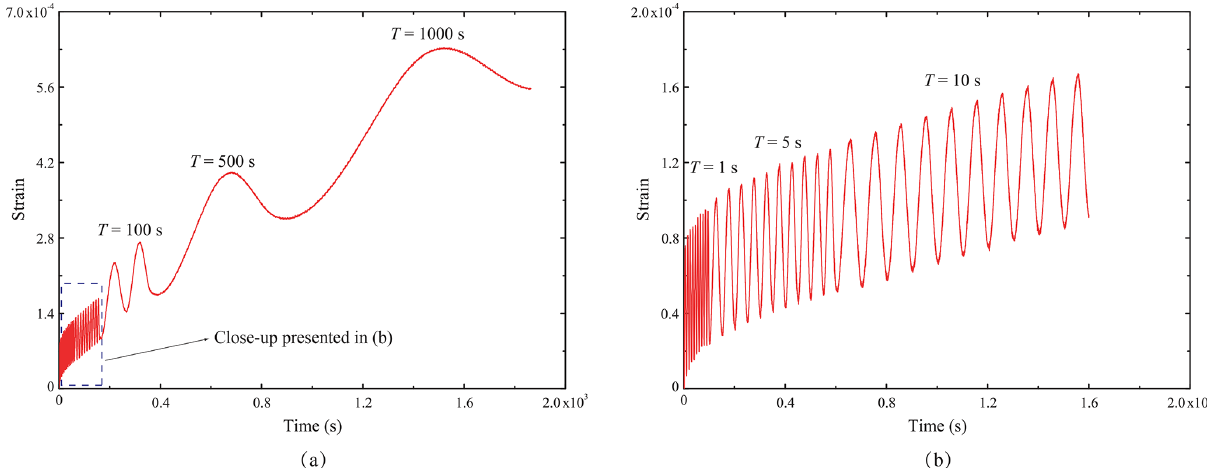
Figure 10. Strain response of specimen Floating-5ppt-1 tested with stresses varying from 0.04 to 0.12MPa and with an average temperature of − 2 . 5 ◦ C: (a) shows the response for all periods, T , of cyclic loading, while (b) presents a close-up showing the cycles for T = 1, 5 and